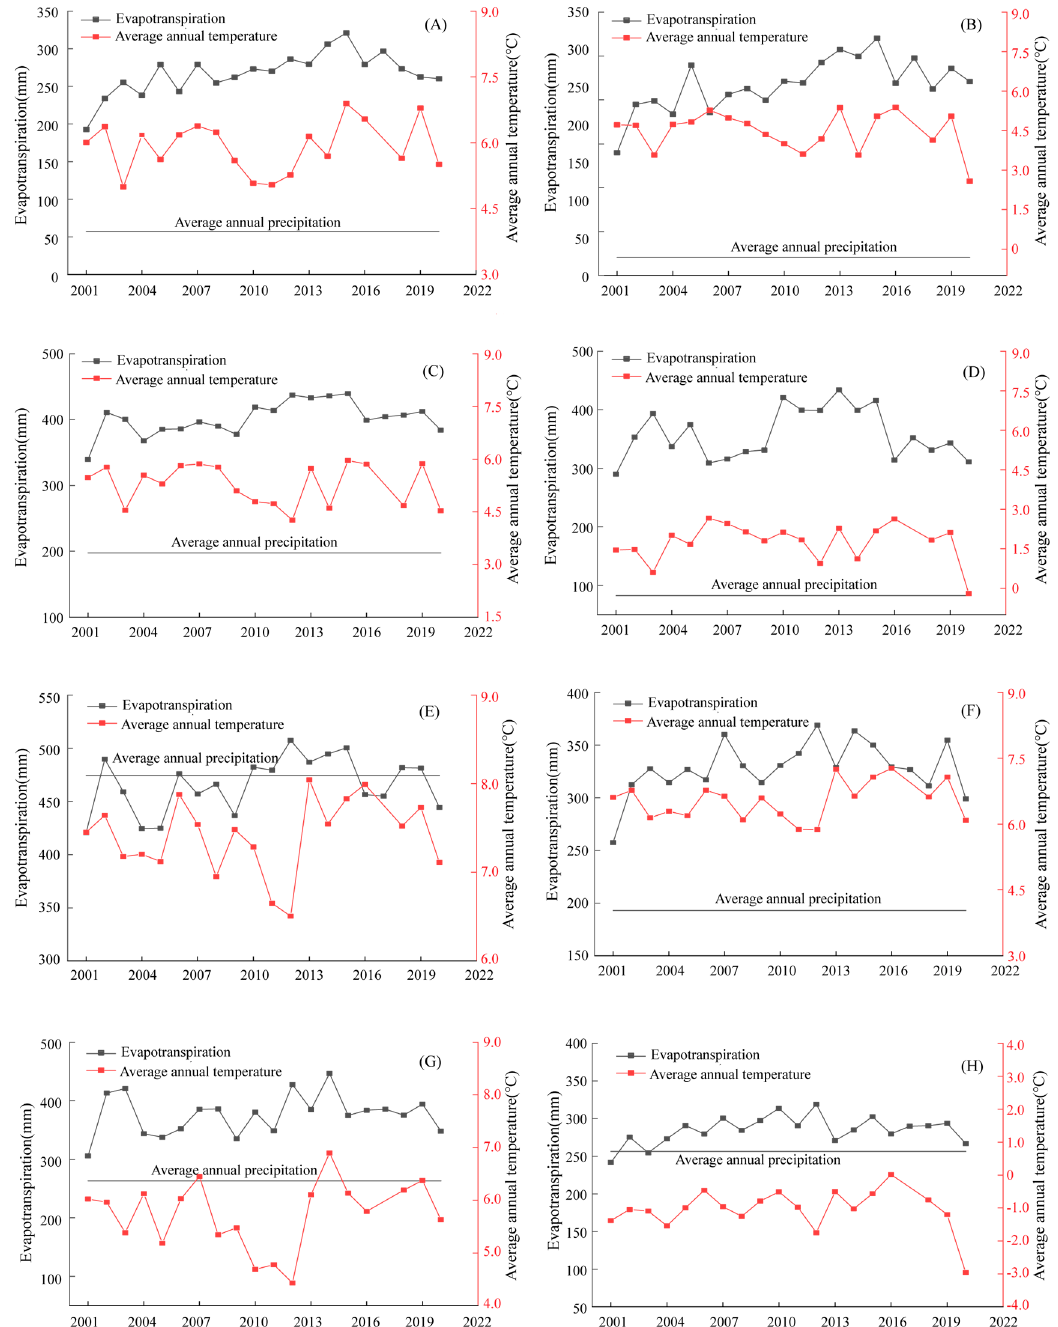
Figure 5. Meteorological variation trend of northwest ‘Water Three Lines’ area from 2001 to 2020. Among them, ( A – H ) represent Northwest Xinjiang, Southwest Xinjiang, Northeast Xinjiang, Southeast Xinjiang, Yellow River Basin, Qaidam Basin, Hexi Inland River Basin, and Semi-arid grassland district area respectively.